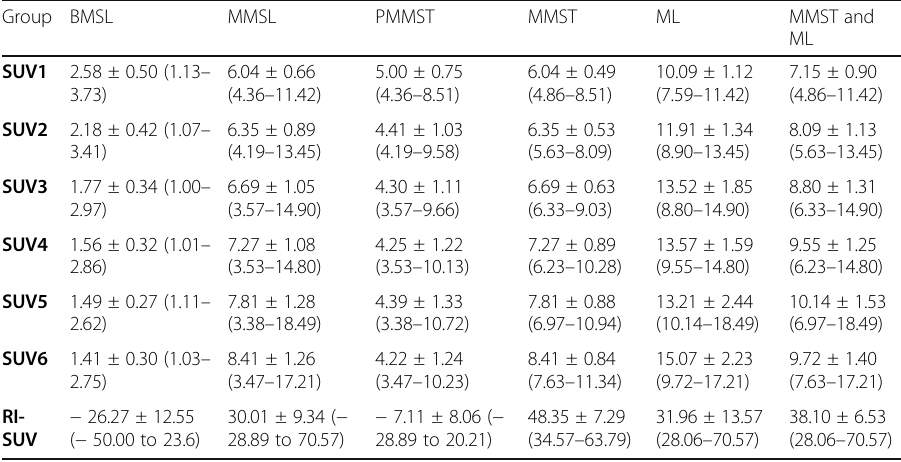
The data represent the median ± standard error of the mean; data in parentheses are the ranges SUV standardised uptake value, RI-SUV retention index of maximum standardised uptake value, BMSL benign